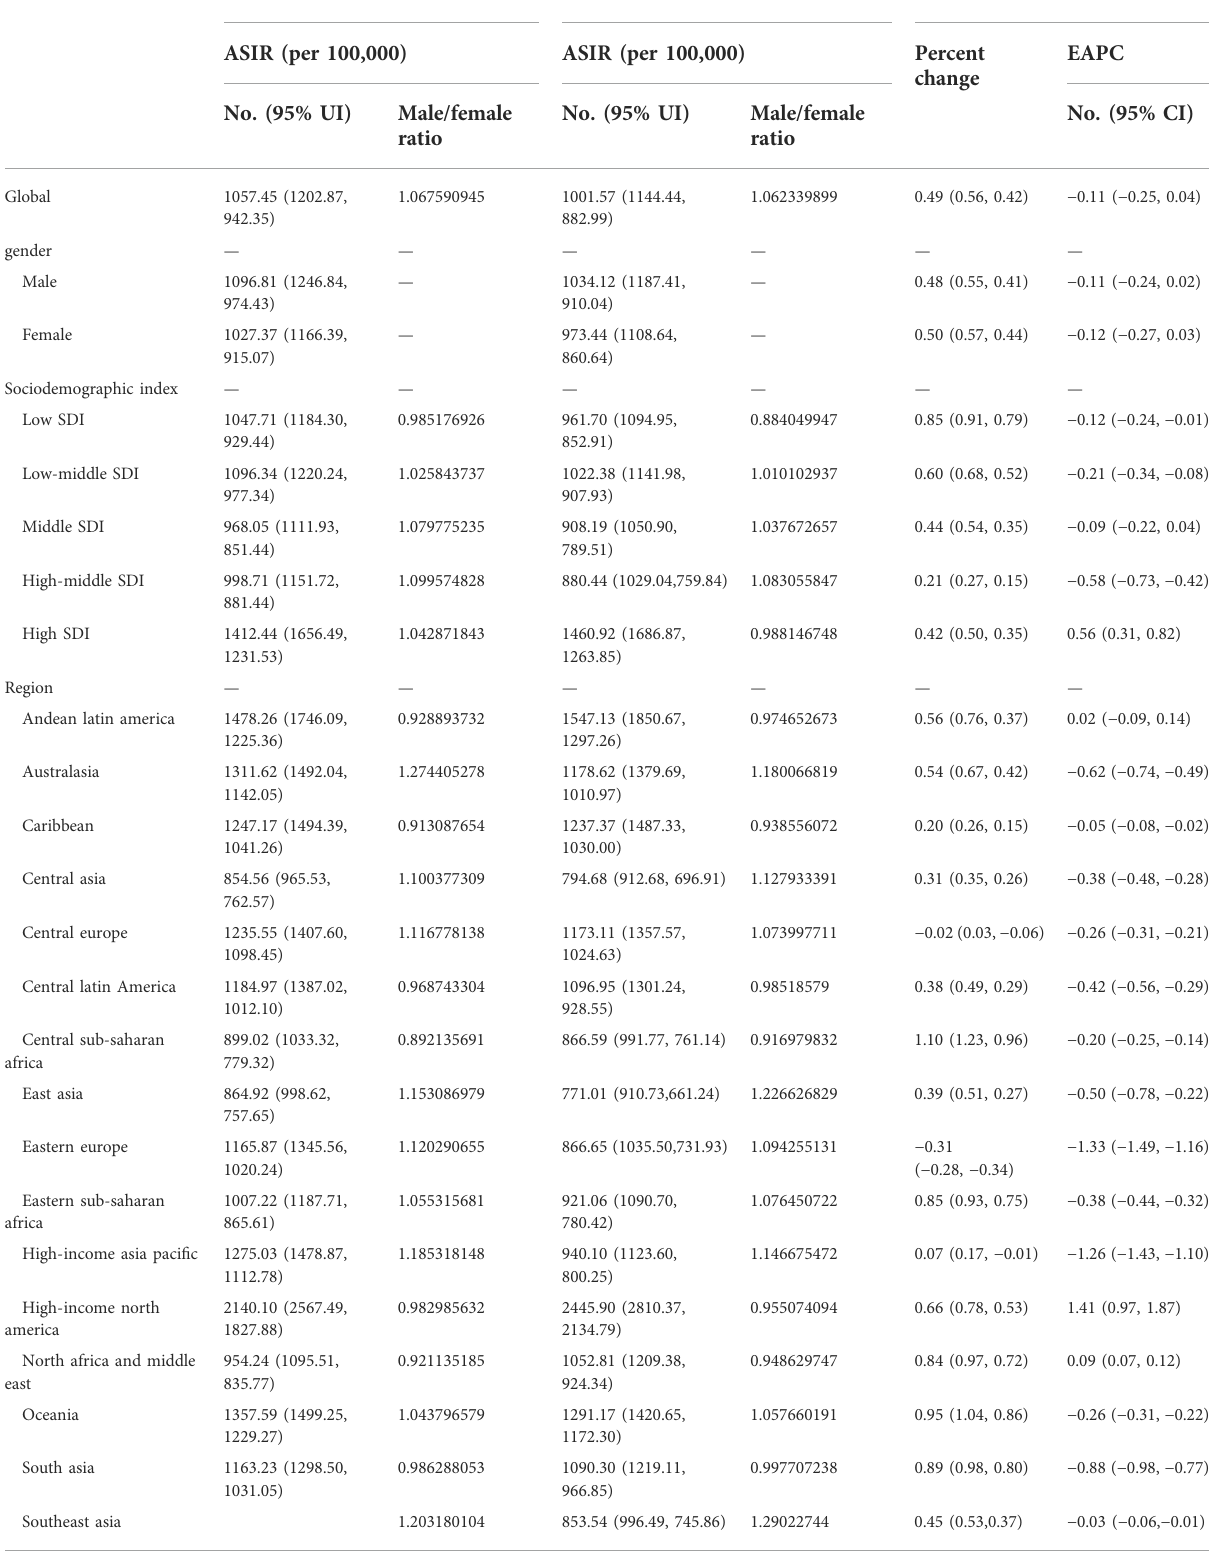
TABLE 1 The age-standardized incidence rate (ASIR) of chronic obstructive pulmonary disease in 1990 – 2019 and its temporal trends.